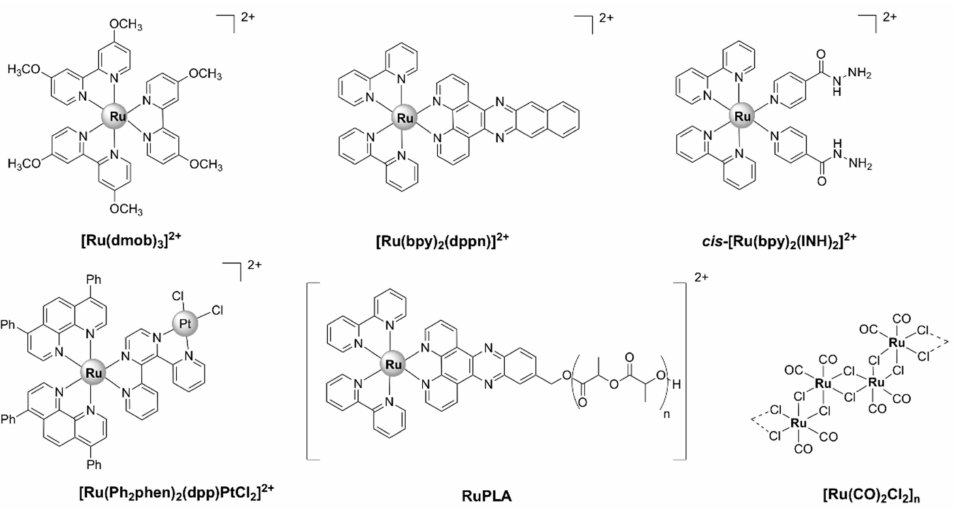
Figure 20. Chemical structures of ruthenium complexes developed for Antimicrobial Photodynamic